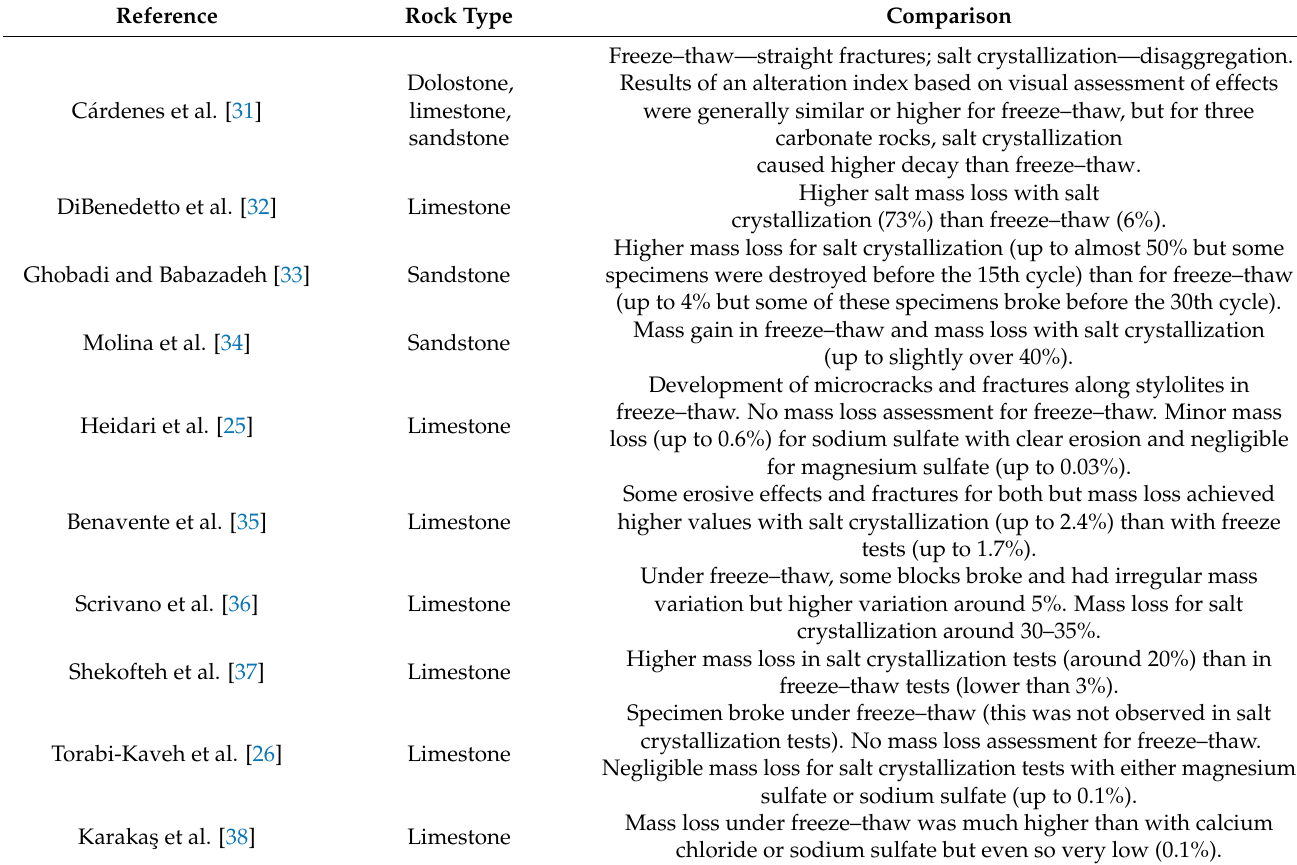
Table 1. Analysis of comparative studies of salt crystallization (sodium sulfate unless indications otherwise) and freeze–thaw on sedimentary rocks.